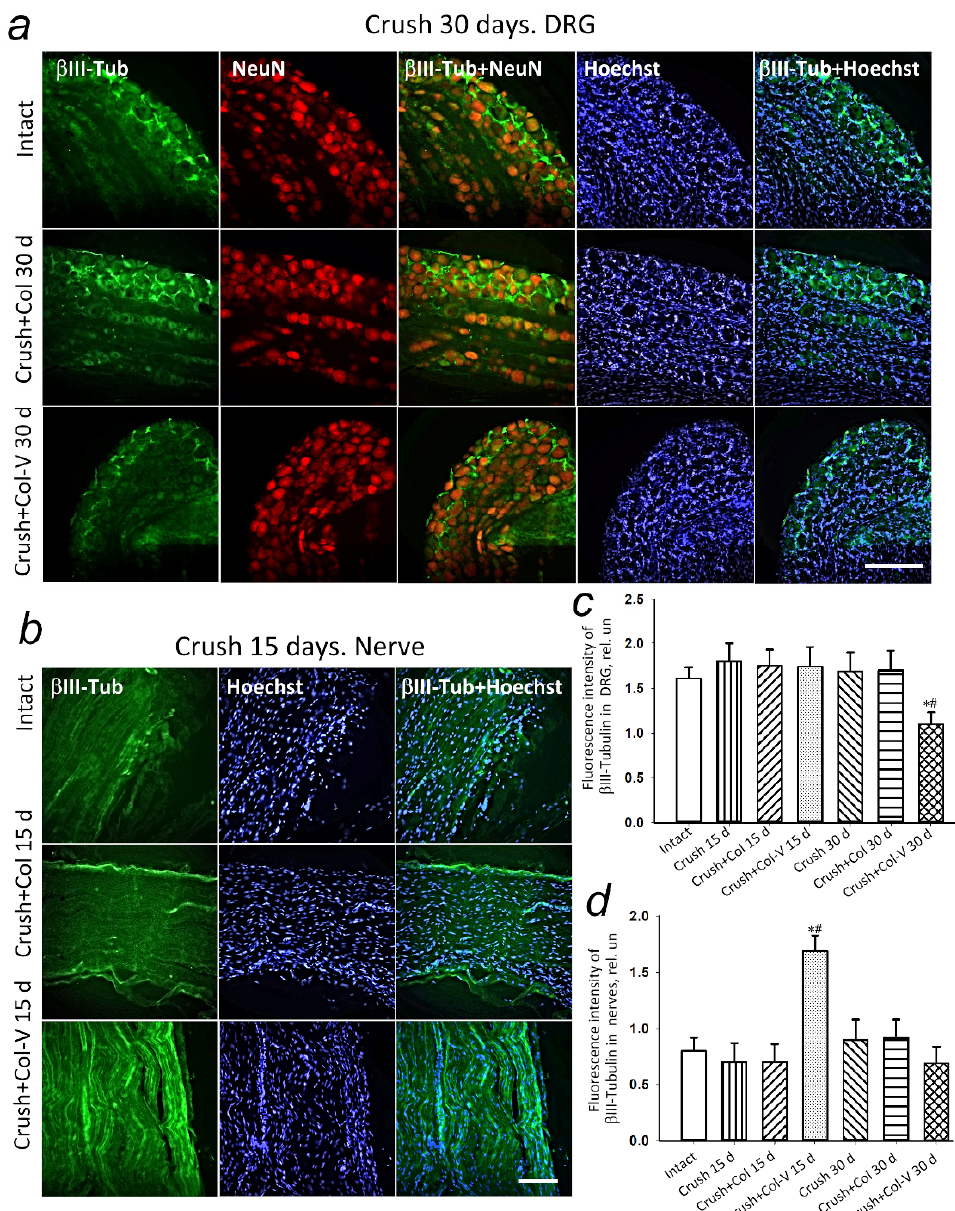
Figure 7. ( a ) Representative immunofluorescence images of β III-tubulin protein (green) in dorsal root ganglia (DRG) of intact rats and 30 days after nerve crush (Crush), with gel-only application (Crush+Col), with vesicle treatment (Crush+Col-V), and combined fluorescence images of β III-tubulin with NeuN (red, neuronal marker) and β III-tubulin and Hoechst (nuclear marker, blue). Scale bar: 50 µ m. ( b ) Representative immunofluorescence images of β III-tubulin protein (green) in the sciatic nerve site (Nerve) of intact rats and 15 days after nerve crush (Crush), with only gel application (Crush+Col), with vesicle treatment (Crush+Col-V), and combined fluorescence images of β III-tubulin with Hoechst (nuclear marker, blue). Scale bar: 50 µ m. ( c ) Relative fluorescence intensity of β III-tubulin in the dorsal root ganglia (DRG) of rats at different times after crushing, with and without vesicle treatment. ( d ) Relative fluorescence intensity of β III-tubulin in the nerve (Nerve) at 0.5–1 cm from the injury site in rats at different times after crushing, with and without vesicle treatment; n = 7. M ± SEM; * p < 0.05 compared with respective group without vesicle treatment; # p < 0.05 compared to intact nerve, One-Way ANOVA with Tukey’s post hoc